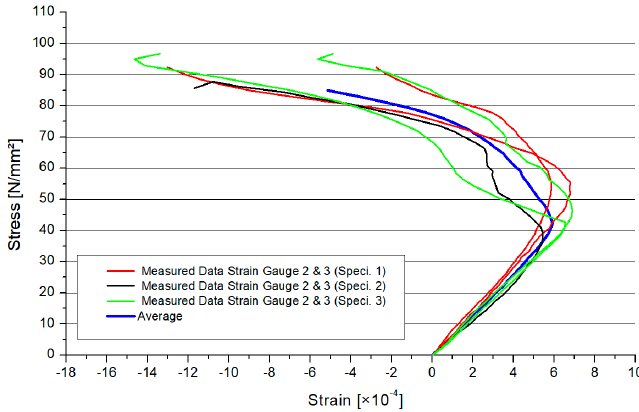
Figure 11. Von-Mises stress distribution and deformation.